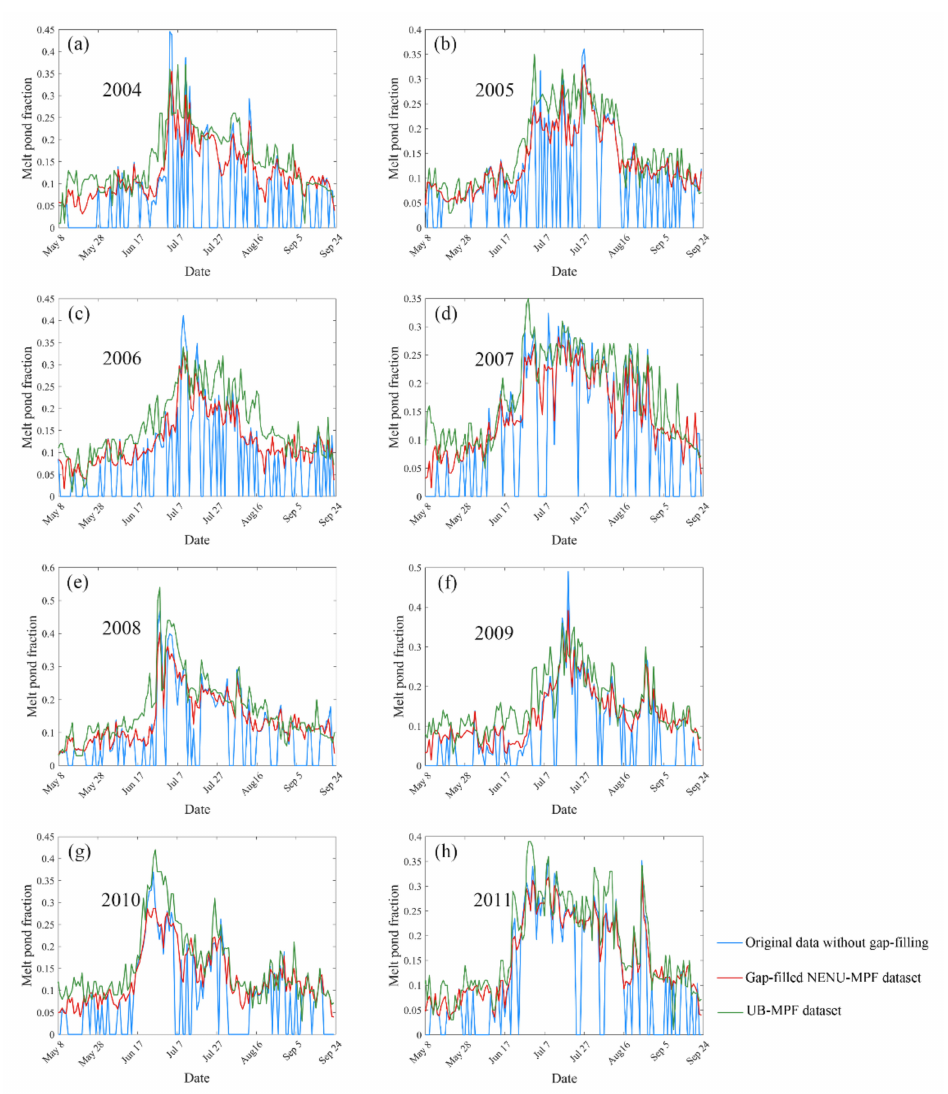
Figure 11. Example of MPF data processed using the statistical-based temporal filter (137 ◦ 46 (cid:48) 0.41”W, 74 ◦ 33 (cid:48) 9.33”N) in ( a ) 2004, ( b ) 2005, ( c ) 2006, ( d ) 2007, ( e ) 2008, ( f ) 2009, ( g ) 2010, and ( h ) 2011,